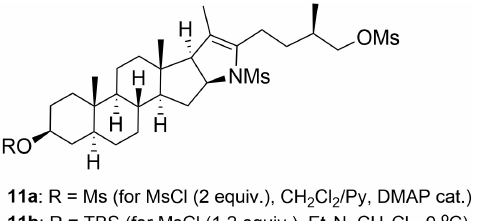
Figure 3. Major products of imine 4 mesylation under harsh